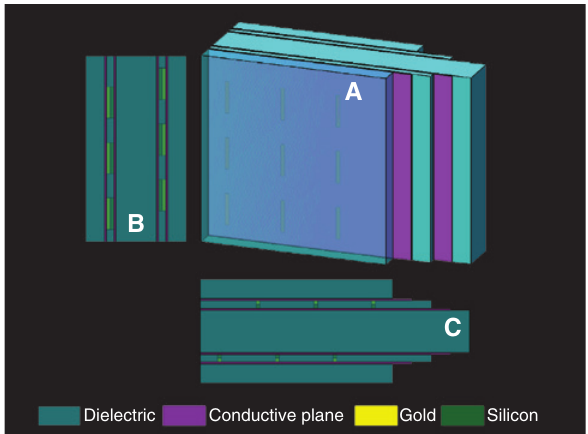
Figure 8: Schematic illustration of hot-electron photodetection based on the PC-SCPA in our optical system possessing the phase coupling. (A) The structure of hot-electron photodetection. (B) The right view of hot-electron photodetection. (C) The top view of hot-electron